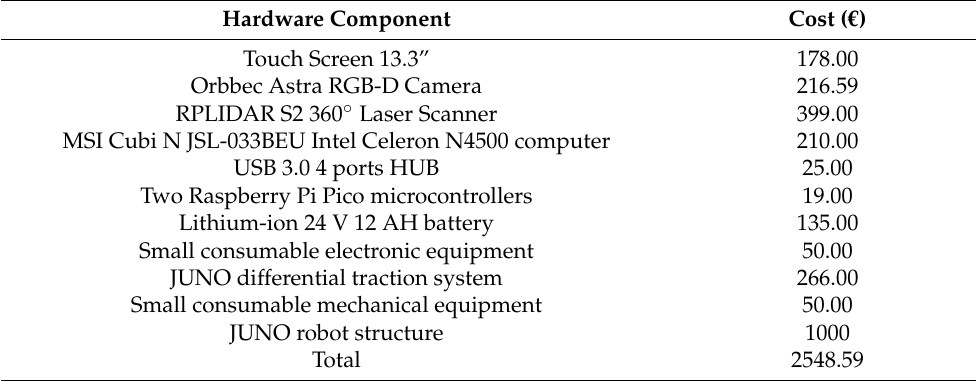
Table 1. List of components for the JUNO robotic platform, with its economic cost.